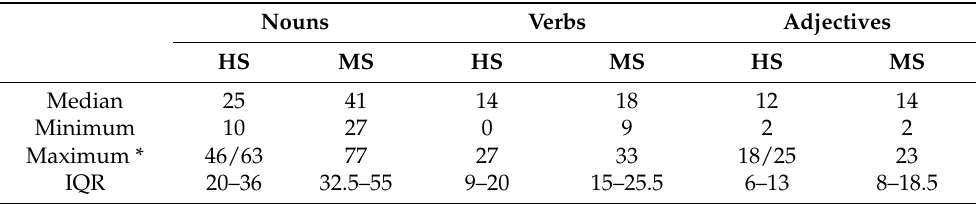
Table 1. Lexical distribution and variation per group of European Portuguese (EP) speakers regarding the subcorpora. Nouns Verbs